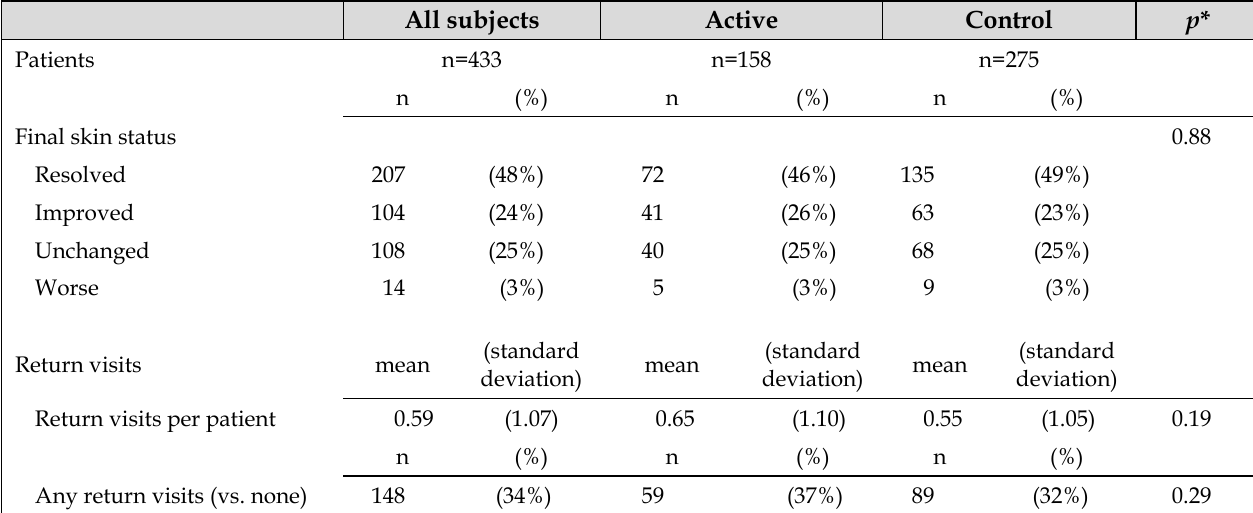
Table 2 Problem resolution and return visit outcomes All subjects